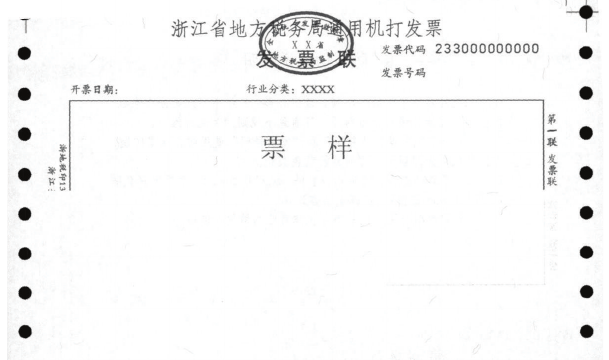
Figure 6: The invoice